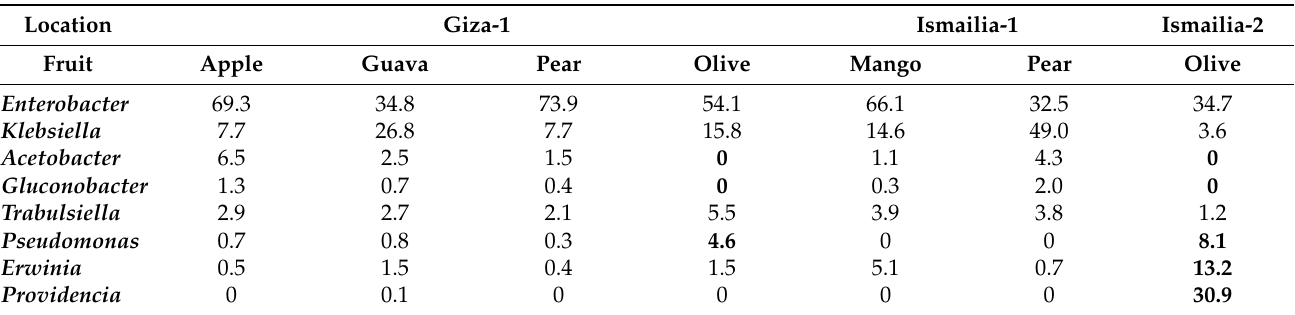
Table 5. Relative abundance of bacterial genera in microbiomes associated with female adults of B. zonata from different origins (in % of all analyzed